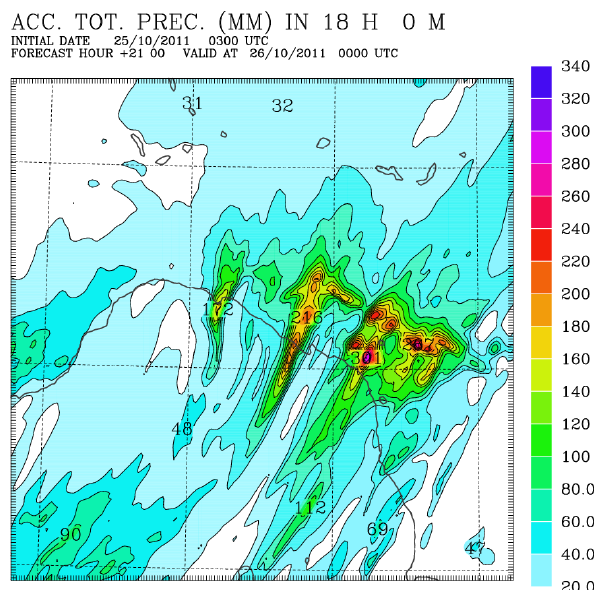
Figure 8. Same as Fig. 7c but for ECMWF-IFS analysis. Max.